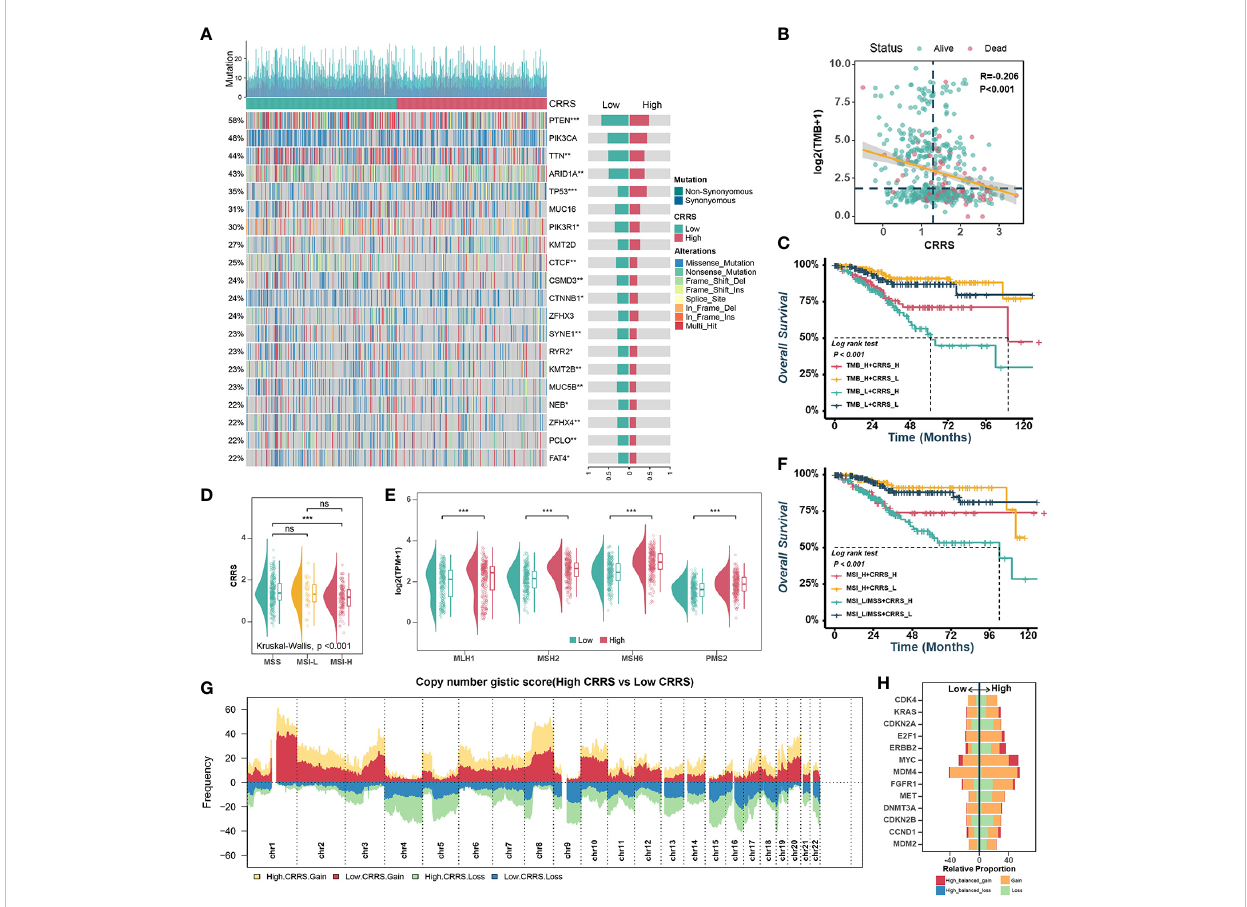
FIGURE 5 Comprehensive analyses of genomic alterations in different risk groups. (A) . Oncoplots of the top 20 most frequently mutated genes in the TCGA- UCEC dataset. Each column represents an individual patient. The small fi gure above shows the non-synonymous and synonymous mutation counts (log2). The fi gure on the right shows the mutation rates of different groups. (B) . Scatter plots showing the correlation between the CRRS and TMB. The color indicates different survival statues. (C) . Survival analyses for subgroup patients strati fi ed by both CRRS and TMB. (D) . The prevalence of CRRS in the MSS, MSI-L, and MSI-H groups. (E) . Comparisons of MLH1, MSH2, MSH6, and PMS2 between low- and high-CRRS groups. (F) . Survival analyses for the subgroup of patients strati fi ed by both CRRS and MSI. (G) . Gain and loss frequency in the low- and high-CRRS groups. (H) . The CNV of some representative oncogenes and tumor